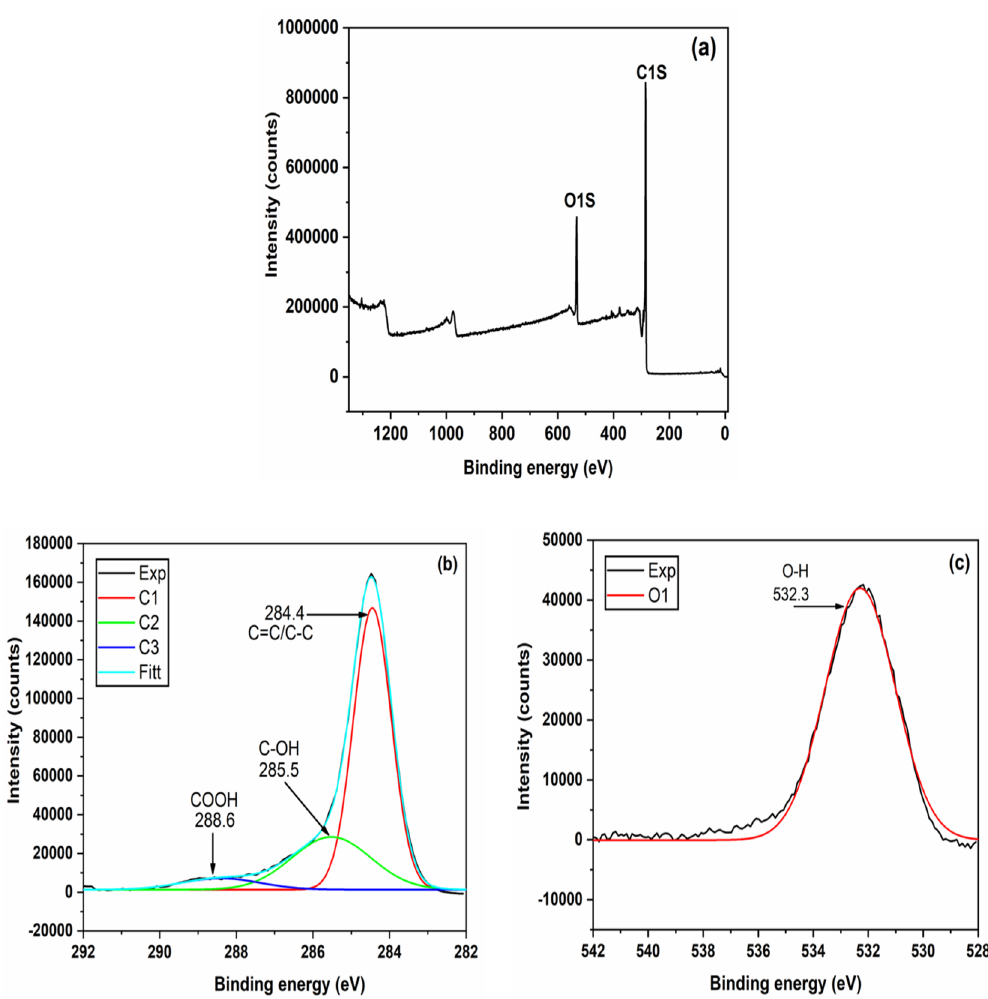
Figure 5. XPS spectra of engineered biochar (a) survey scan, (b) carbon and (c) oxygen element.